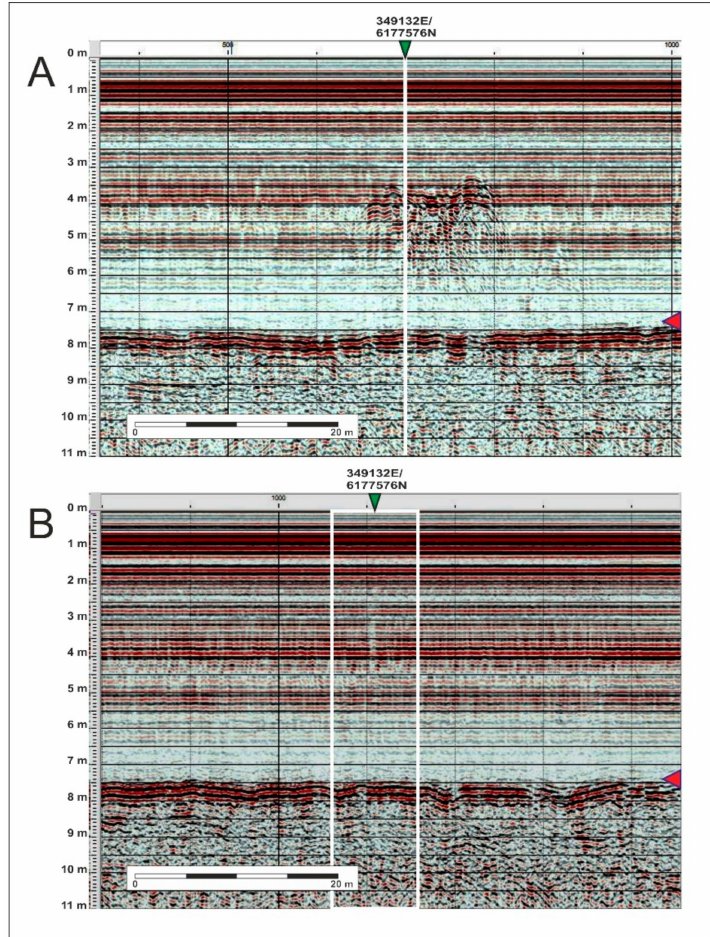
Figure 18. ( A ): Profile 21 showing a clear haystack feature around its intersection with profile 27 at point 349132E/6177576N (shown with a green arrow above). ( B ): A section of profile 27 displaying a weak and narrow noise column at its intersection with profile 21 at point 349132E/6177576N (marked with a green arrow above and a white frame). Seafloor marked with red arrow to the right. Depth scale to the left. UTM 33 coordinates. Graphics: